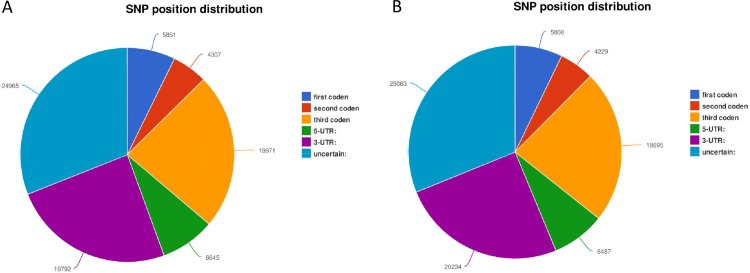
Positions of single nucleotide polymorphisms (SNPs).A SNP positions in the transcriptomes of MNOP. B SNP position in the transcriptomes of MNON.